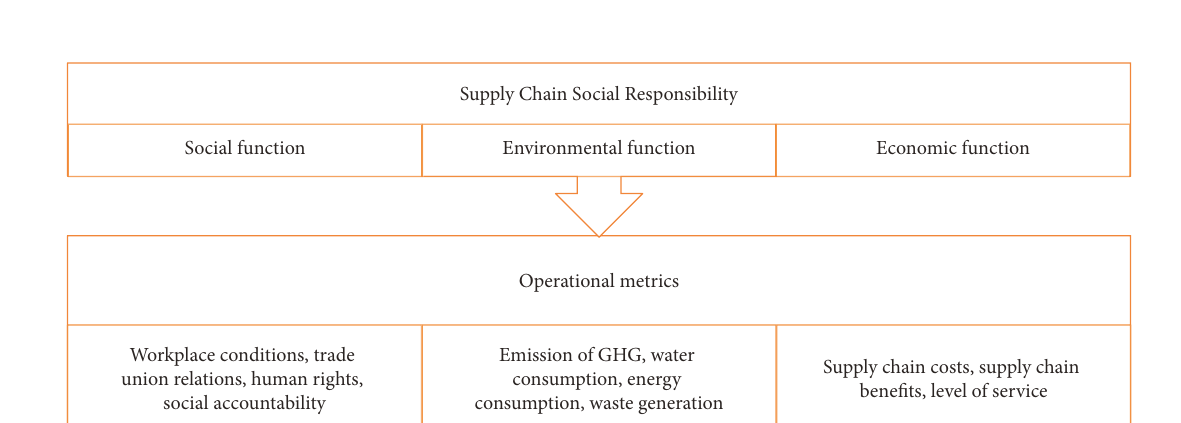
Figure 2: Framework of social responsibility in the supply chain.